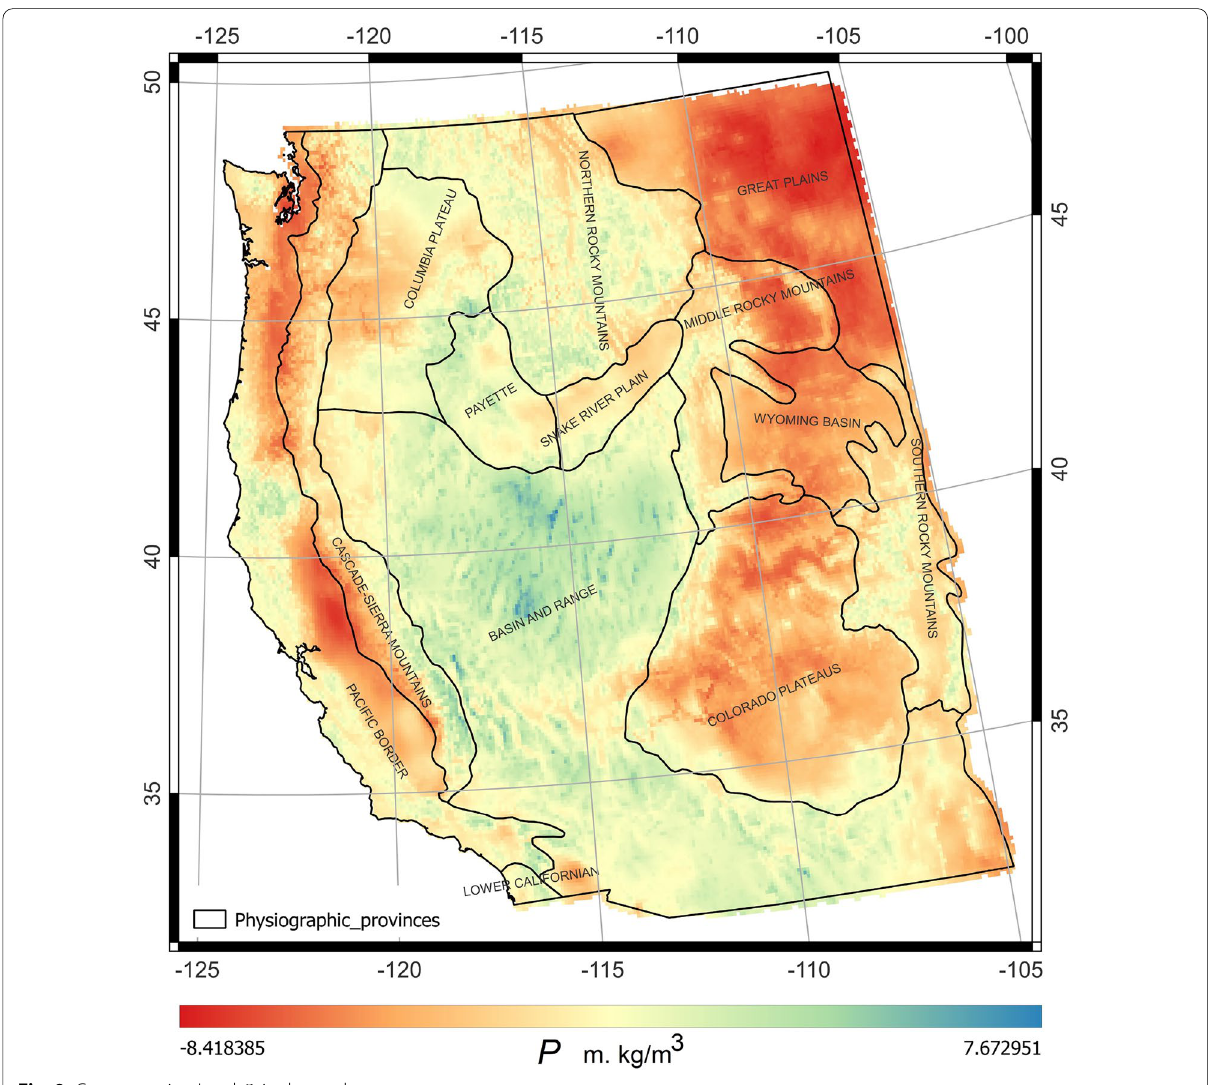
Fig. 9 Compensation Load, P , in the study